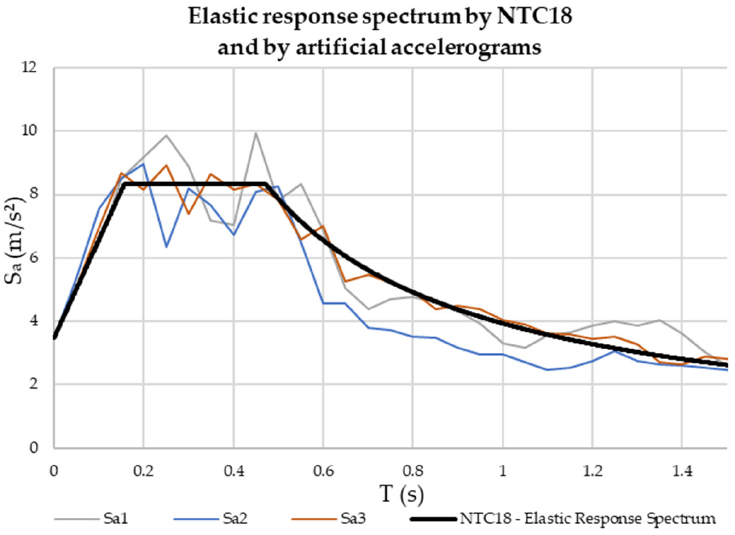
Figure 9. Elastic response spectrum from NTC18 and from artificial accelerograms generated by SIMQKE.